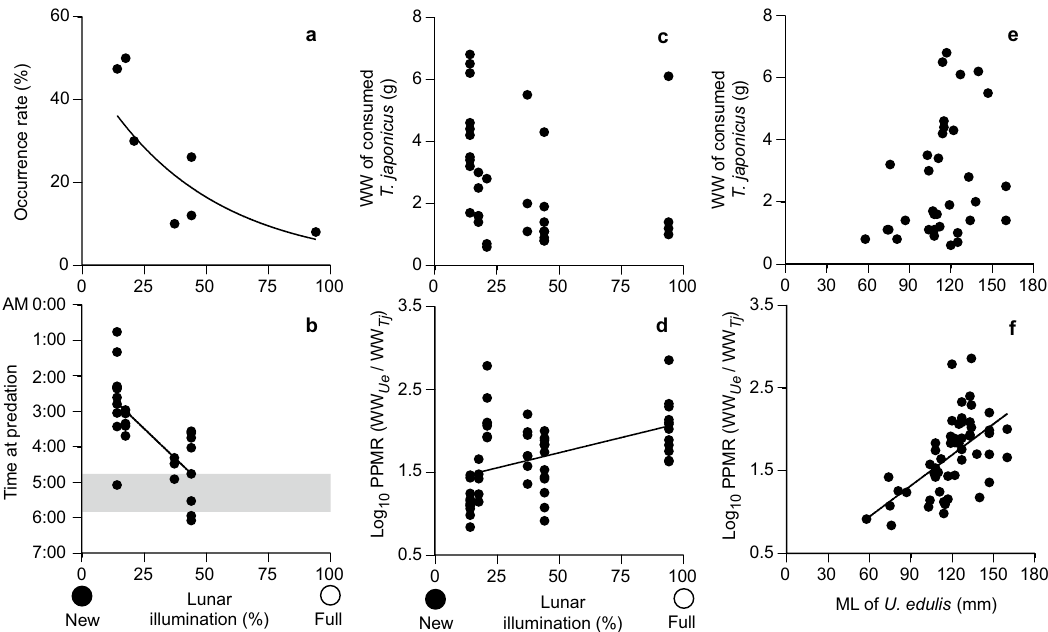
Figure 3. Predation of Trachurus japonicus juveniles in relation to lunar illumination. ( a ) Occurrence rate and ( b ) time at predation. Shaded area in ( b ) indicates twilight time approximately one hour before sunrise. ( c – f ) Wet weight of the consumed T. japonicus juveniles ( c , e ) and predator–prey mass ratio (PPMR) ( d , f ) in relation to lunar illumination and Uroteuthis edulis mantle length (ML). Solid lines indicate significant relationships between